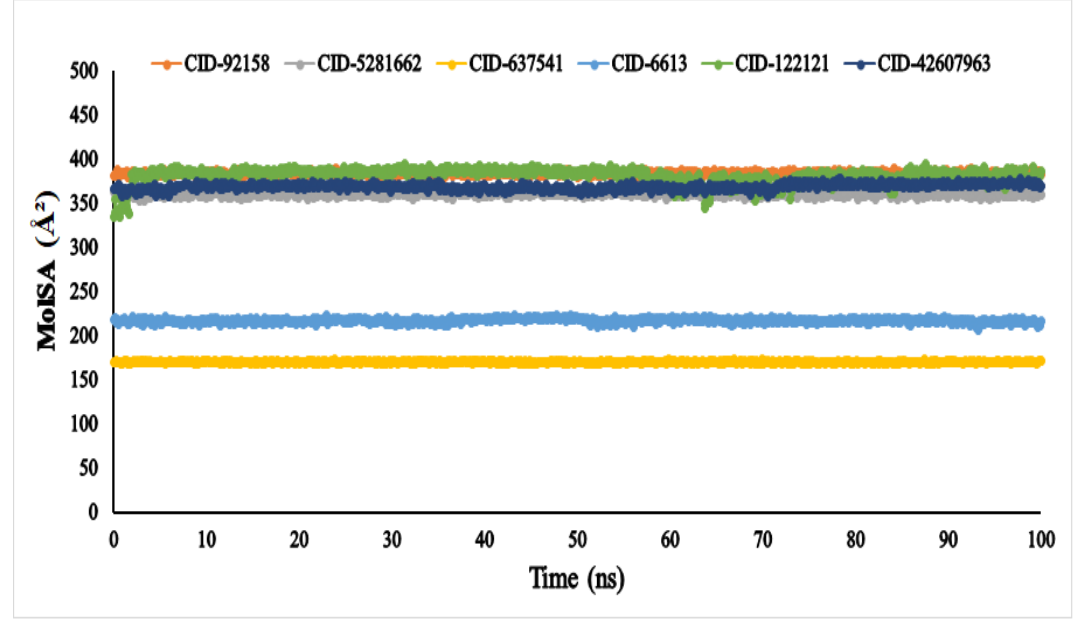
Figure 7. The molecular surface area (MolSA) of the of the selected six compounds, viz., lupenone (CID: 92158), swertianolin (CID: 5281662), m -coumaric acid (CID: 637541), pantothenic acid (CID: 6613), phytosphingosine (CID: 122121), and 8- C -glucopyranosyleriodictylol (CID: 42607963), in association with the targeted protein α -glucosidase (PDB ID: 3A4A) are shown by specific colour.